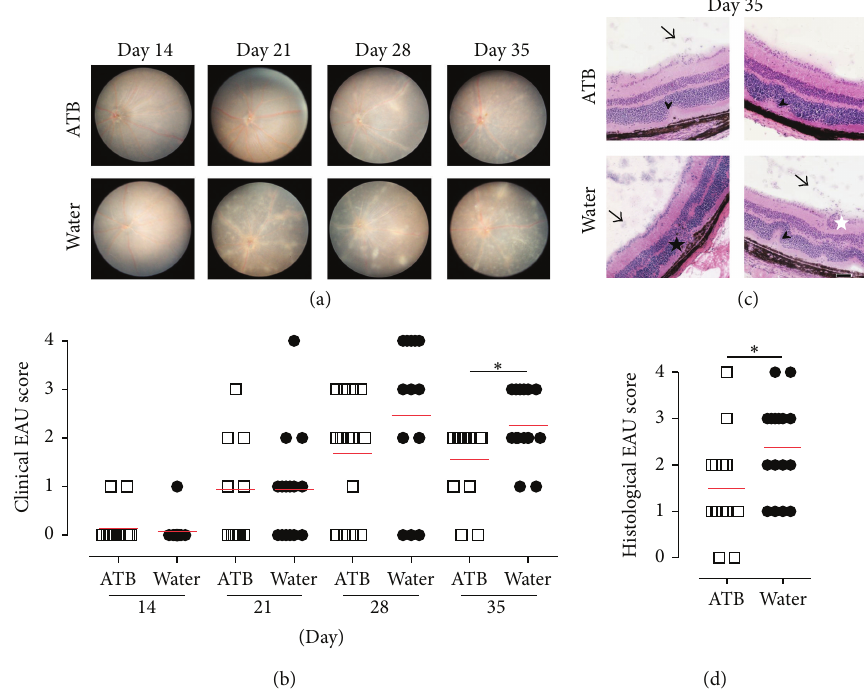
Figure 2: Reduced severity of EAU in mice treated with antibiotics (ATB) from one week before EAU induction (15 animals). Mice treated with metronidazole and ciprofloxacin commencing one week prior to EAU induction and continued for the course of the experiment had significantly lower levels of EAU compared to controls (15 animals) both clinically and histologically. (a) Representative photographs of retinal fundusatdays14,21,28andday35afterEAUinductionshowthedevelopmentofocularpathologyinATBandcontrolmice.(b)Quantification of clinical EAU score. The red lines in the graphs represent mean. ∗ 𝑝 < 0.05 (Mann-Whitney test). (c) Representative microphotographs of hematoxylin and eosin-stained retina of ATB-treated and control mice at day 35 after induction. Fewer signs of inflammation are present in ATB-treatedcomparedtocontrolmice,includingcellsinthevitreous(arrows)andsmallretinalfolds(arrowheads),retinalneovascularization (black star), and vasculitis (white star). (d) Quantification of histological EAU score is shown. The red lines in the graphs represent mean. ∗ 𝑝 < 0.05 (Mann-Whitney